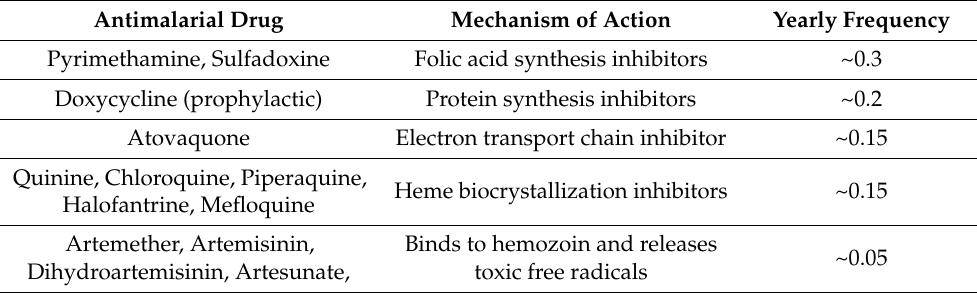
Table 1. Cyclic resistance frequency and antimalarial drug